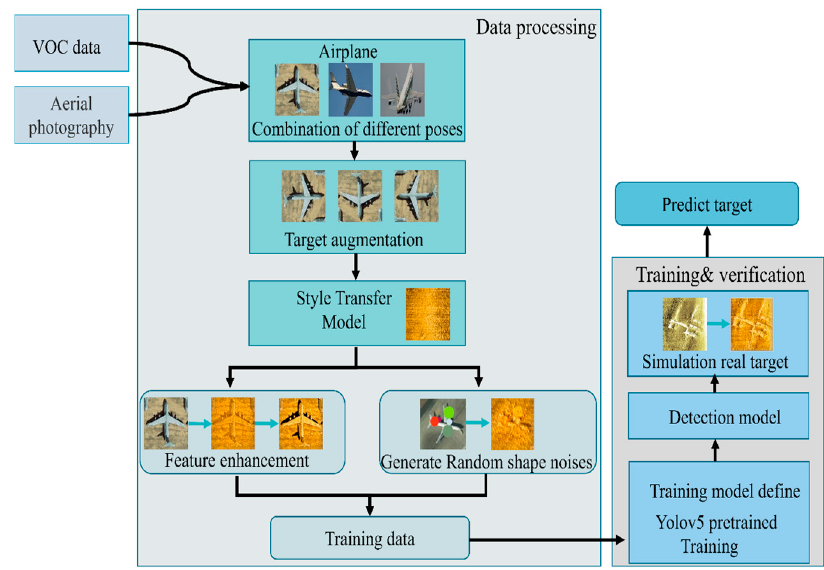
Figure 2. Our process framework.